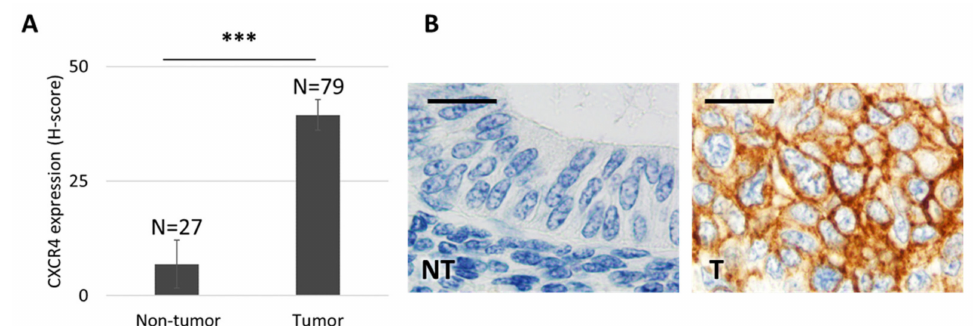
Figure 1. CXCR4 expression in tissue microarrays obtained from endometrial cancer patients. ( A ) CXCR4 is overexpressed in tumor tissue ( n = 79), as compared to adjacent healthy endometrial tissue ( n = 27), that shows almost undetectable CXCR4 expression levels by immunohistochemistry (IHC) (Mann–Whitney test, *** p = 0.000; mean ± s.e.m). ( B ) CXCR4 protein expression after